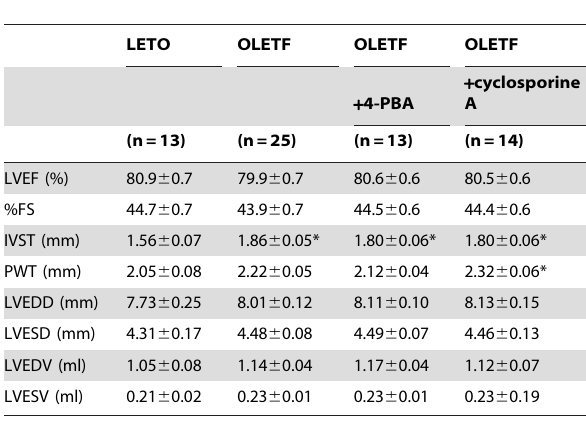
Table 3. Echocardiographic data at baseline.